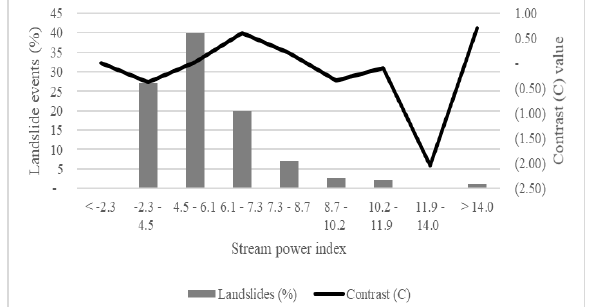
Figure 7 Landslide distribution (%) (left vertical axis) and contrast value (right axis) in relation to stream power index.